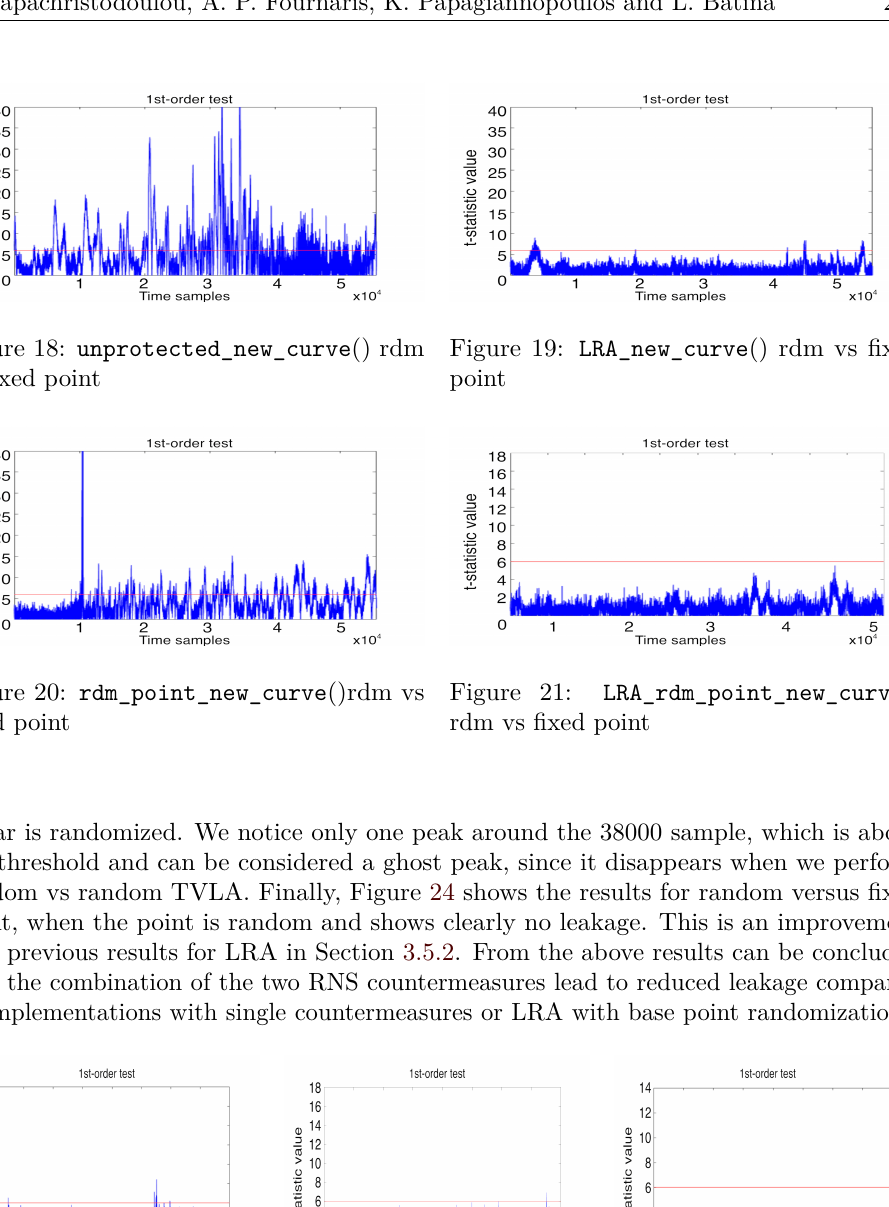
Figure 19: LRA_new_curve () rdm vs fixed point